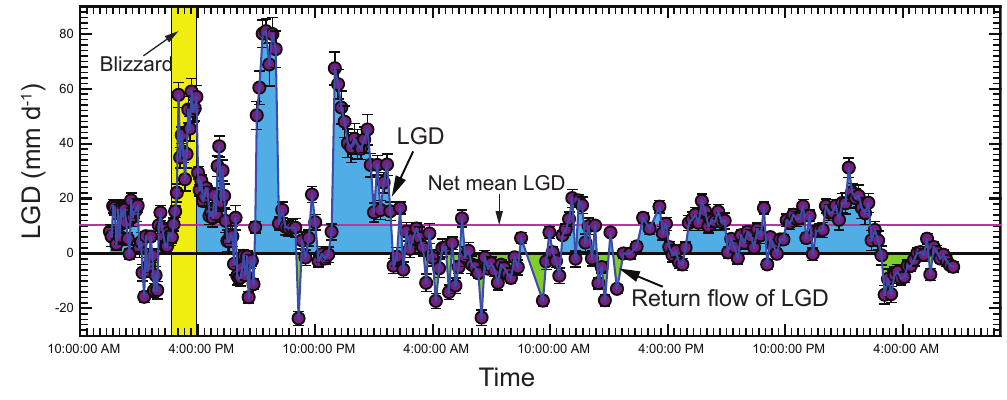
Figure 7. The results of the final LGD derived from the 222 Rn transient